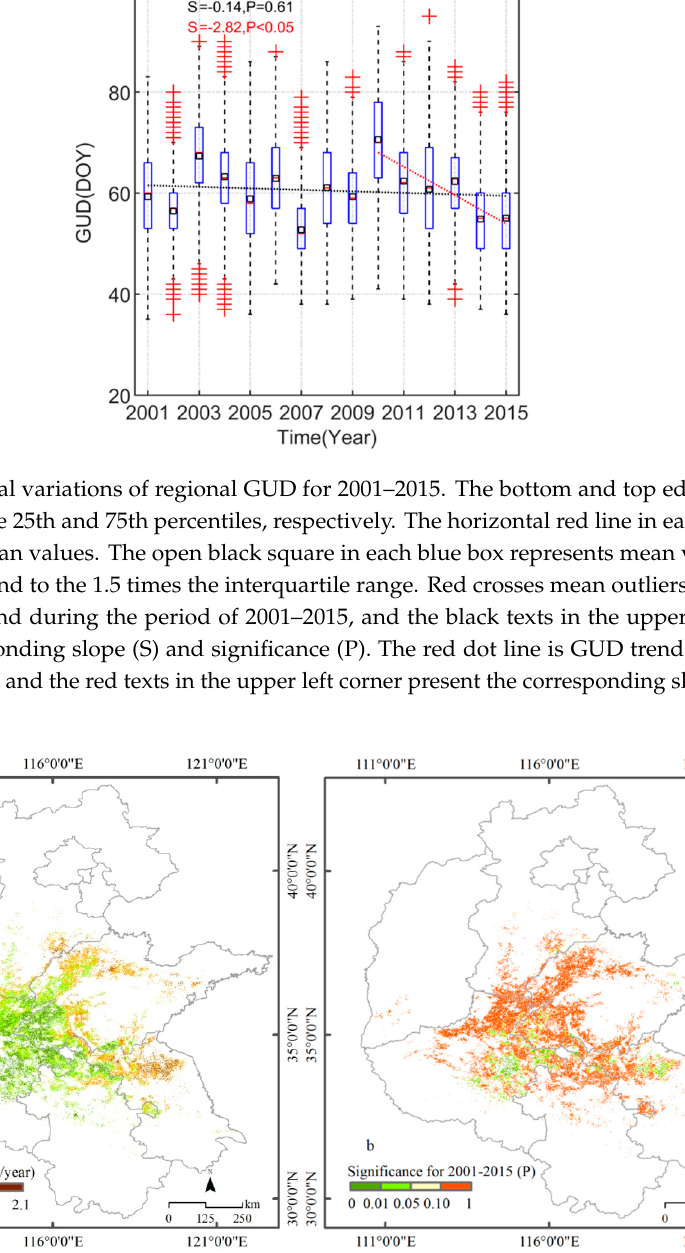
Figure 7. Spatial trends of GUD in the period 2001–2015 ( a ), and its significance levels ( b ). The inset plot presents the frequency percentage of GUD trends. AS, ANS, DS and DNS indicates advanced significantly, advanced but not significantly, delayed significantly, delayed but not significantly, at p < 0.05 level, respectively.